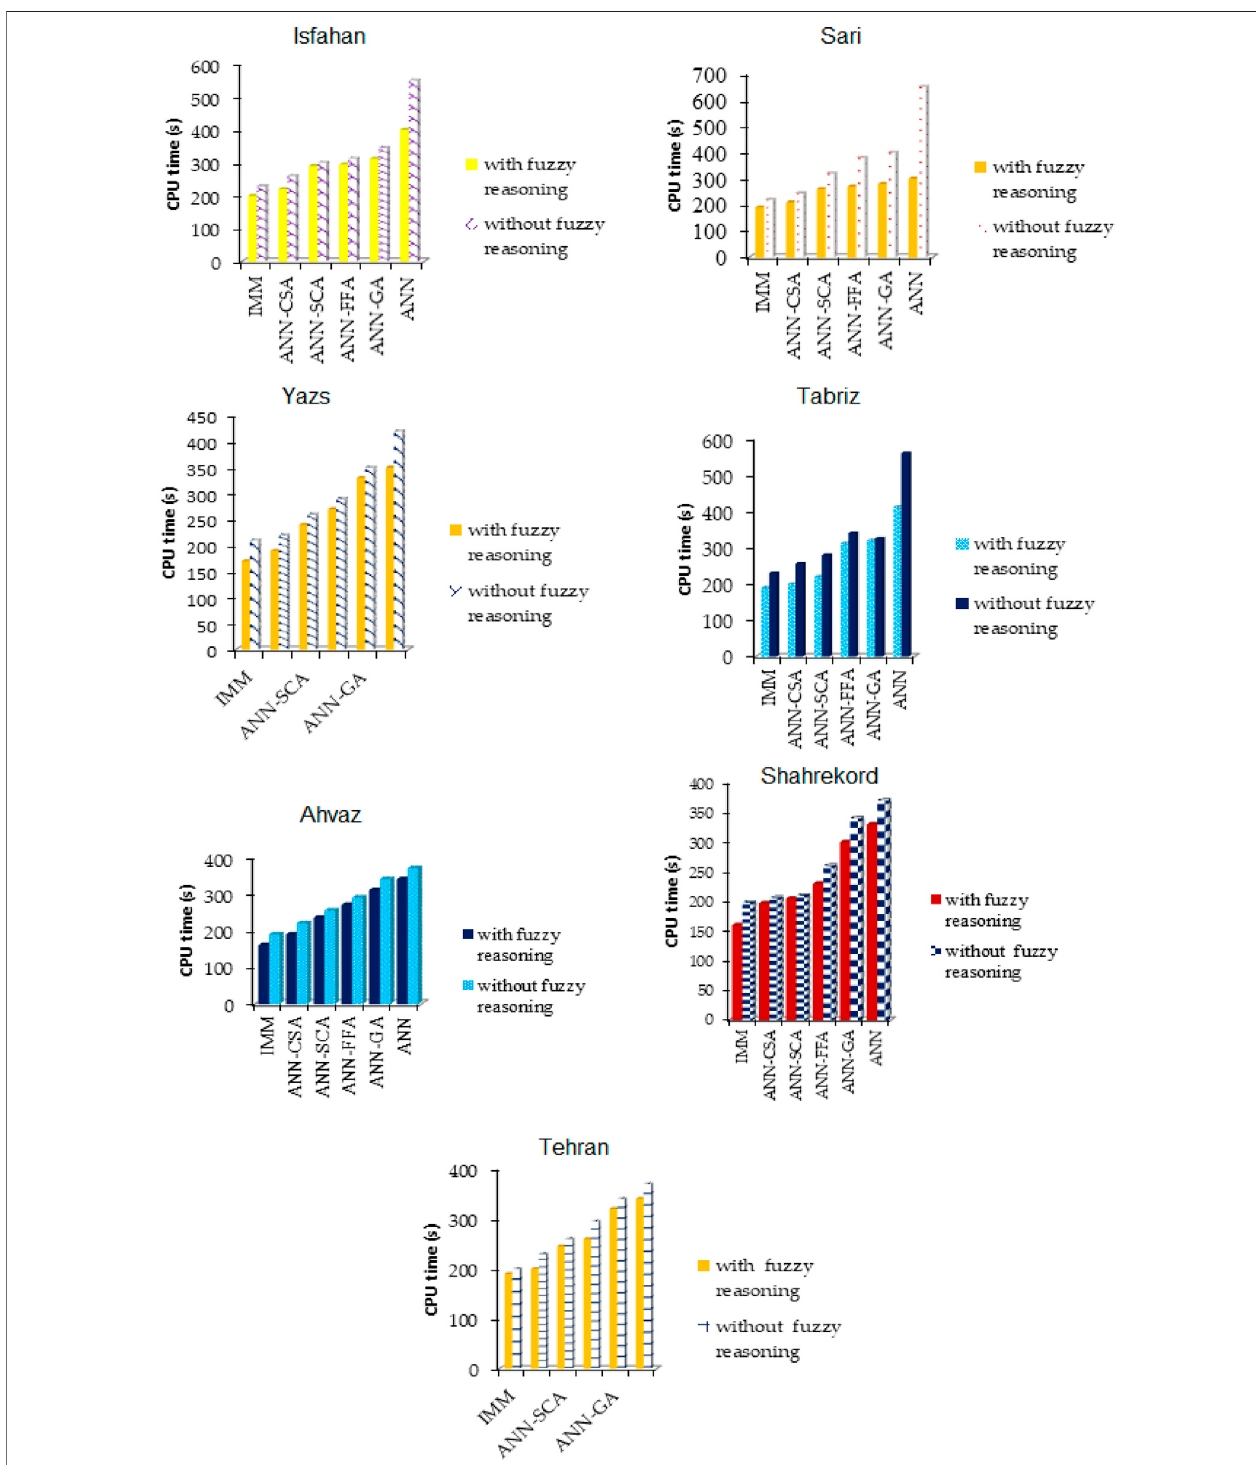
FIGURE 3 | The CPU time of models with and without fuzzy reasoning.